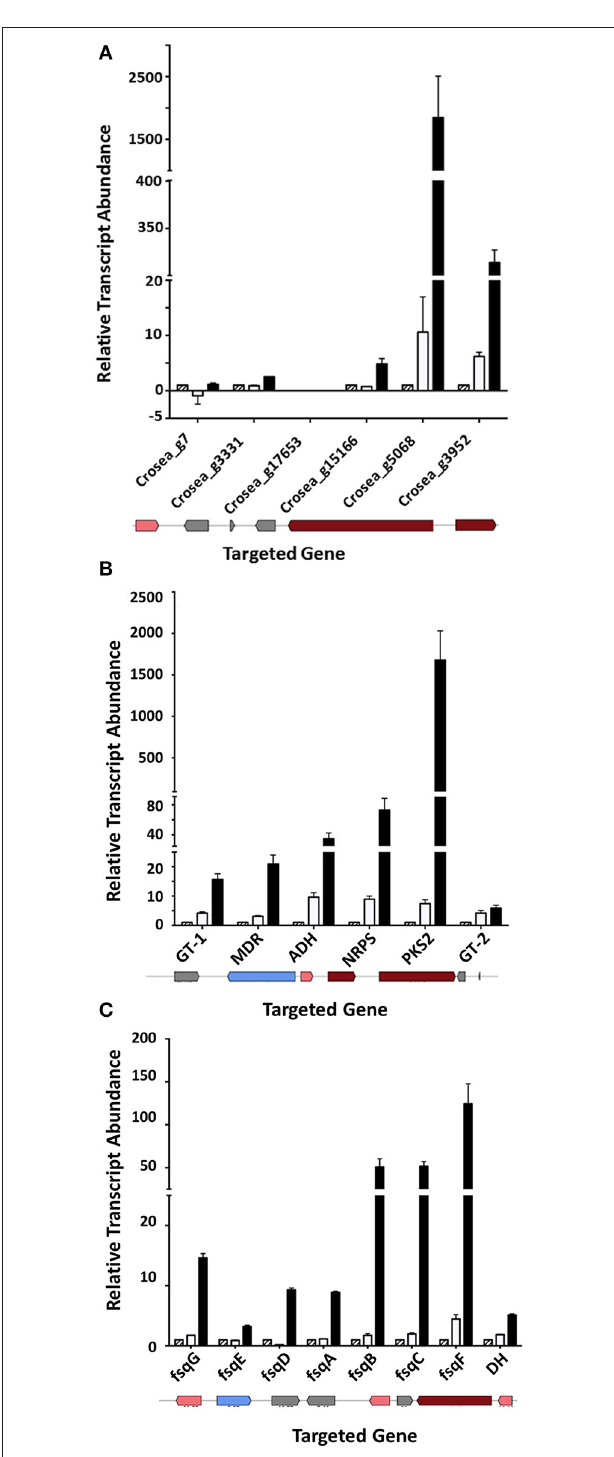
FIGURE 6 | Up-regulated gene clusters in Fusarium -spent media treated AMC941 C. rosea library and their validation. (A) Genomic organization (bottom) and RT-qPCR validation of a putative cluster possibly involved in precursor biosynthesis for polyketide synthetases (Cluster 1). (B) Genomic organization (bottom) and RT-qPCR validation of a putative TMC-151 family